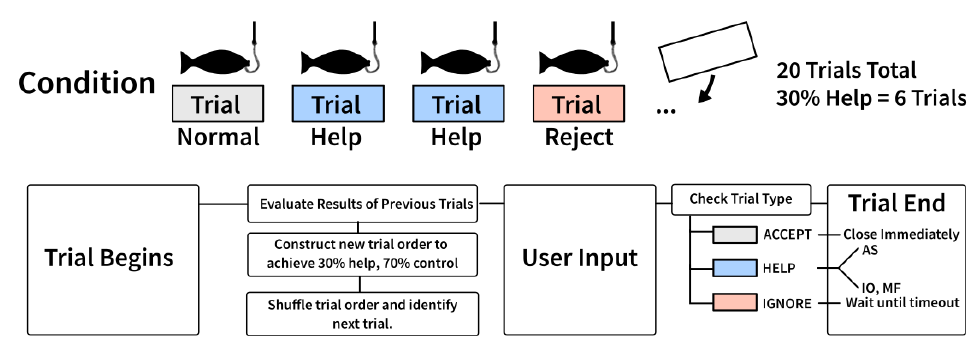
Figure 3. Each condition consisted of 20 trials. In the helped conditions, help trials with predefined outcomes (blue) were shuffled with normal (no PAM) trials (gray) to provide users with 30% help. Forced rejections (red) were inserted when people were succeeding above the 70% target control